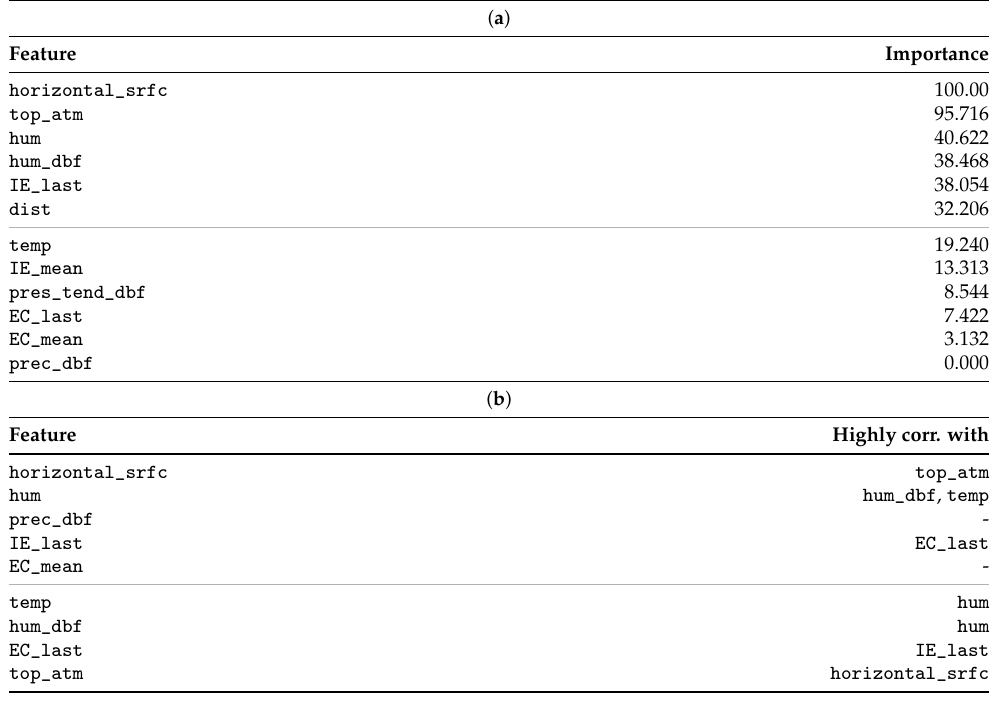
Table 6. A posteriori feature selection for best classification models for each of bacteria. ( a ) feature importance for best ANN for EC_class ; ( b ) selected features for best RF for IE_class based on their correlation with other features. In groups of highly correlated features ( ≥ 0.5), the one with the highest correlation with IE is